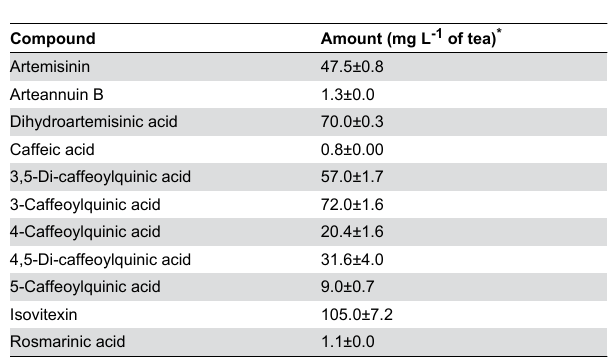
Table 2. IC of extracts and components of A. annua in 50 CQ-sensitive (HB3) and resistant (Dd2)